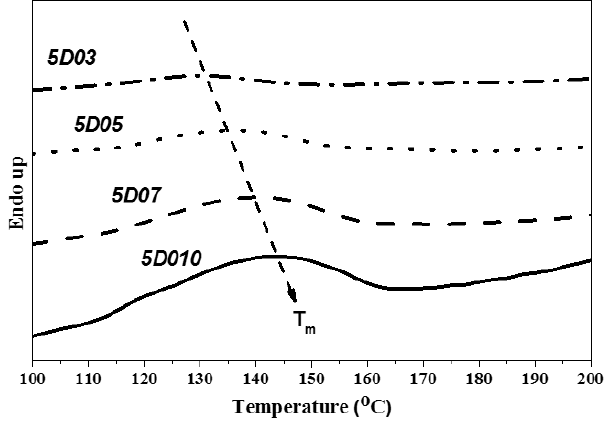
Figure 14. DSC curve of TPU with end-capping agent at concentration of 10 phm.